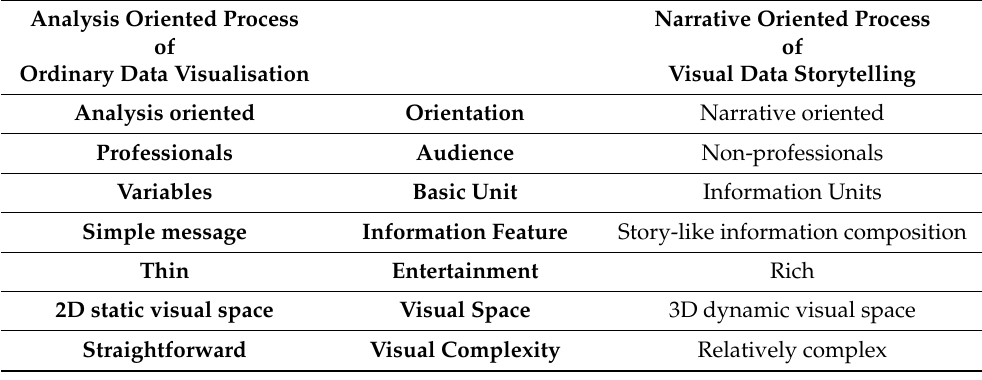
Table 2. Comparing table of regular data visualisation and visual data